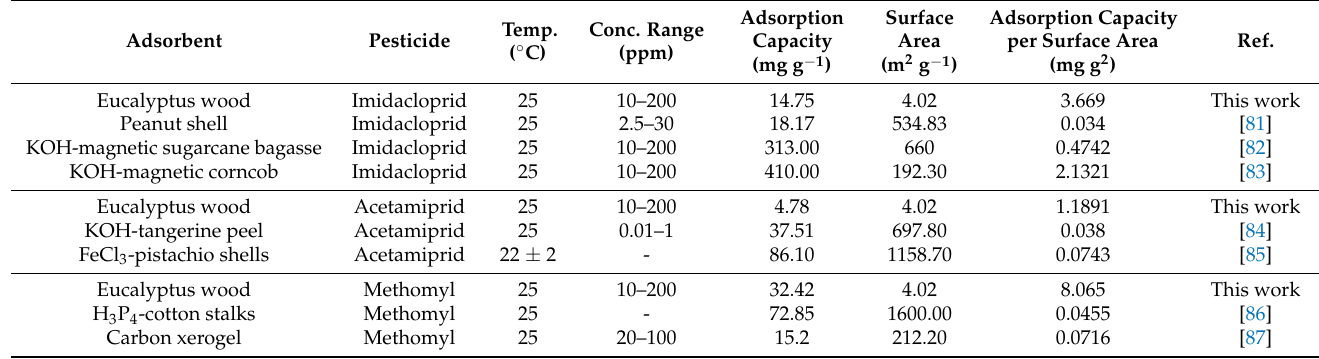
Table 7. Langmuir adsorption capacities of the eucalyptus wood-derived biochar compared with previously reported carbon-based adsorbents from various raw parent